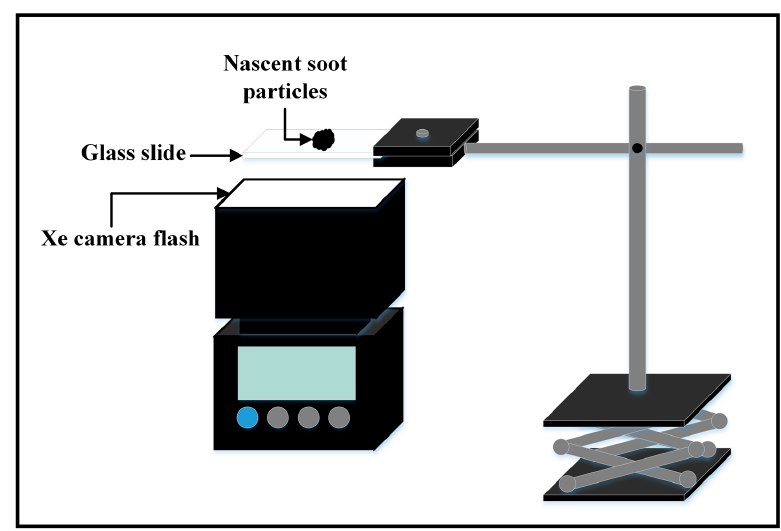
Figure 2. Schematic diagram of flash-exposure experimental setup.